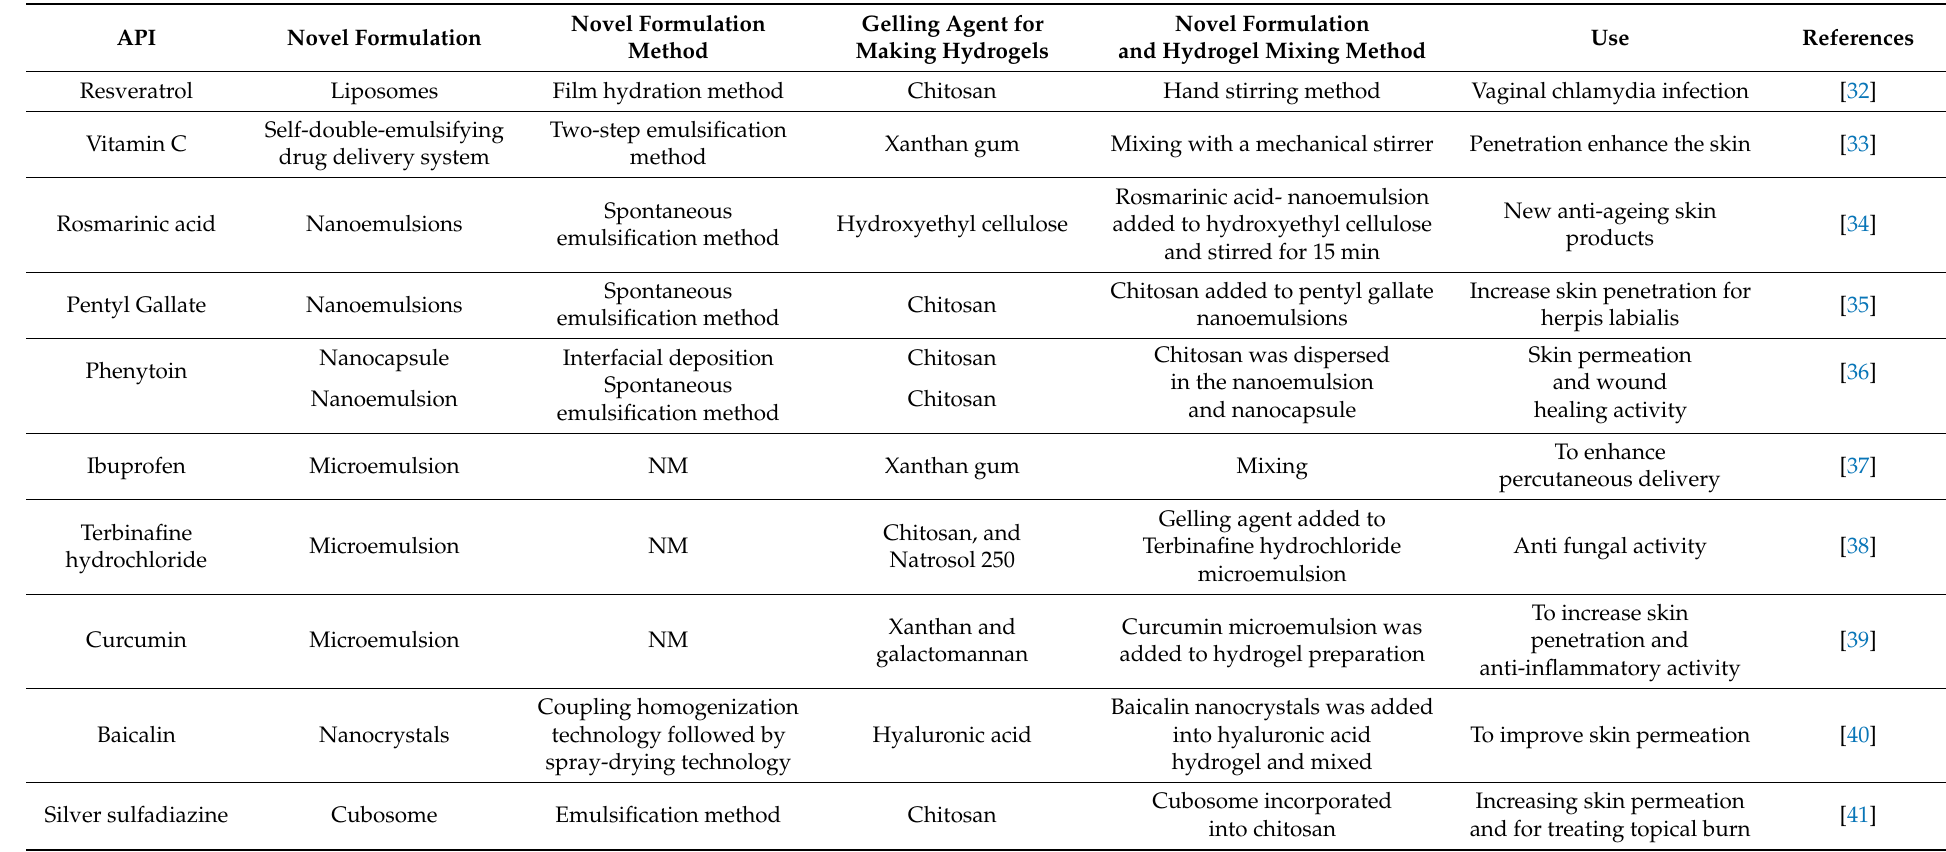
Table 1. Novel formulation formulated with natural gelling agents, preparation methods, mixing with the hydrogels, and its